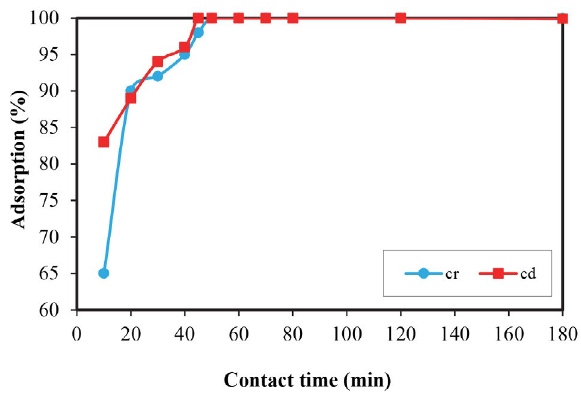
Fig. 7: The effects of time on the cadmium and chromium in condi- tions in terms of (cadmium pH: 6, chromium pH: 7, initial concen- tration of metal ions 20 mg/L, adsorbent dosage 20 g/L and temper- ature 25 °C)